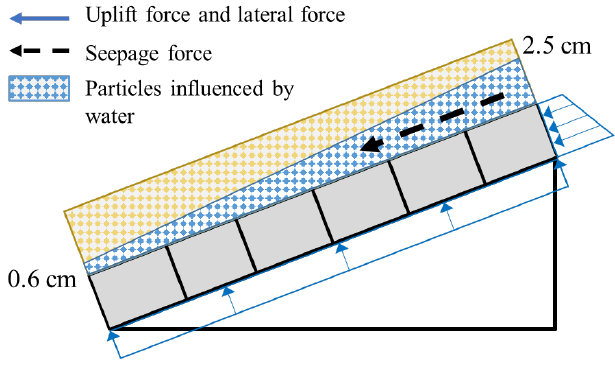
Figure 8. Schematics of water flow influence.